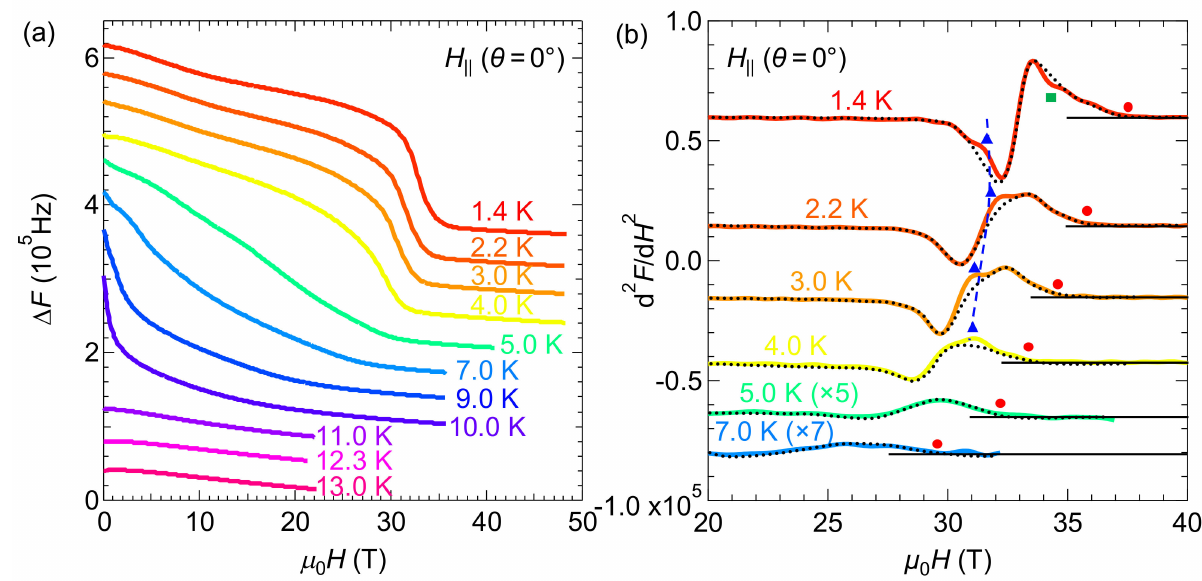
Figure 4. ( a ) ∆ F ( θ = 0 ◦ ) as a function of field at various temperatures. ( b ) Magnetic-field dependence of d 2 F /d H 2 . The symbols and curves are described using the same definitions as those used in Figure